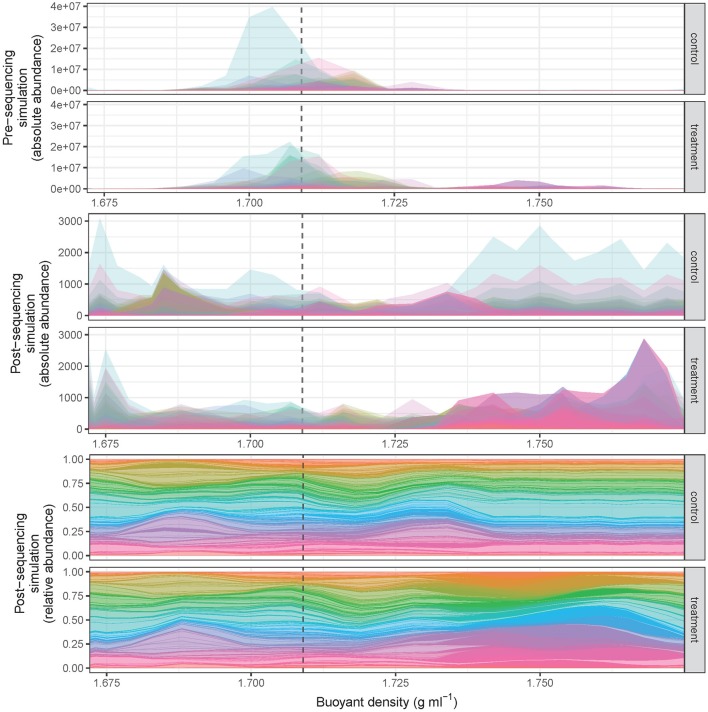
SIPSim output provides data that approximates results obtained from DNA-SIP experiments. The CsCl gradient BD distributions of diverse amplicon fragments (n = 1,147 taxa) are depicted such that the distribution of each taxon is represented by a different color. All taxa in the control had 0% atom excess 13C, while 10% of taxa in the treatment were randomly assigned 100% atom excess 13C. Most unlabeled amplicon fragments occur within the range of 1.69–1.72 g ml−1, while 13C-labeled taxa are shifted into higher BD fractions (pre-sequencing, top panels). During the process of high-throughput DNA sequencing amplicon fragments are randomly sampled from each fraction, and this sampling effect alters the shape of the fragment distributions observed in DNA-SIP experiments (post-sequencing, middle panel) relative to the actual distribution of DNA in the gradient (top panels). Typically, data from DNA-SIP experiments are transformed into relative abundance values (post-sequencing, bottom panel) prior to analysis. Identification of taxa that have incorporated isotope requires comparison of amplicon fragment relative abundance distributions in treatment relative to control gradients. The dashed vertical line is provided as a point of reference and designates the theoretical buoyant density of an unlabeled DNA fragment with 50% G + C (as modeled in Equation 1).